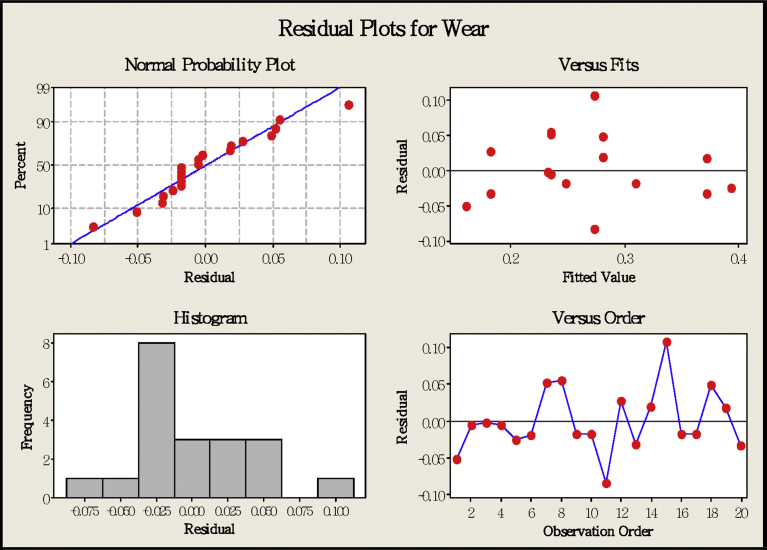
Residual analysis.